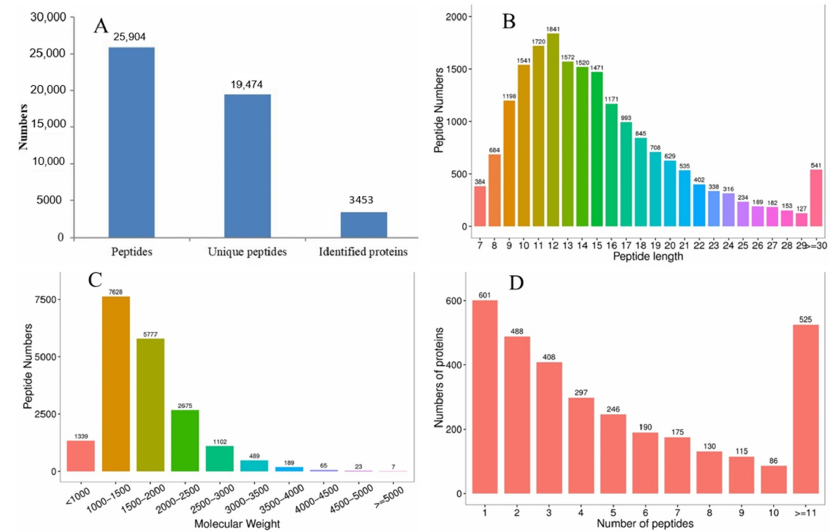
Figure 3. Basic Data-Independent Acquisition (DIA) proteomics analysis output details. ( A ) Pep- tides and protein species identified by a DIA database search; ( B ) length distribution of peptides; ( C ) molecular weight of peptides; ( D ) numbers of peptides that were matched to proteins.